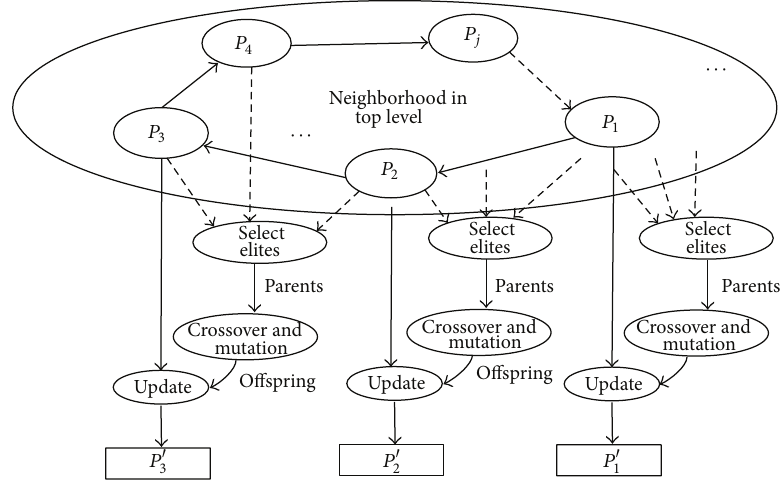
Figure 2: The information exchange mechanism based on crossover operator.